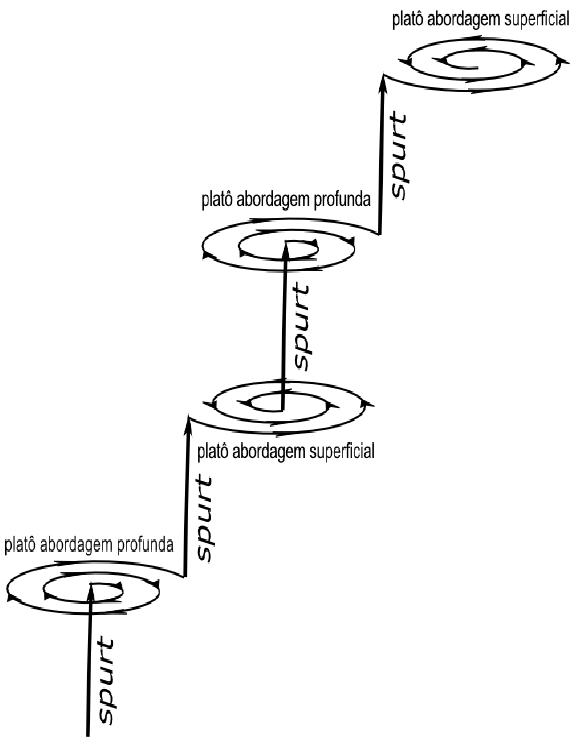
Figura 3. Modelo de Desenvolvimento das Abordagens à Apren-